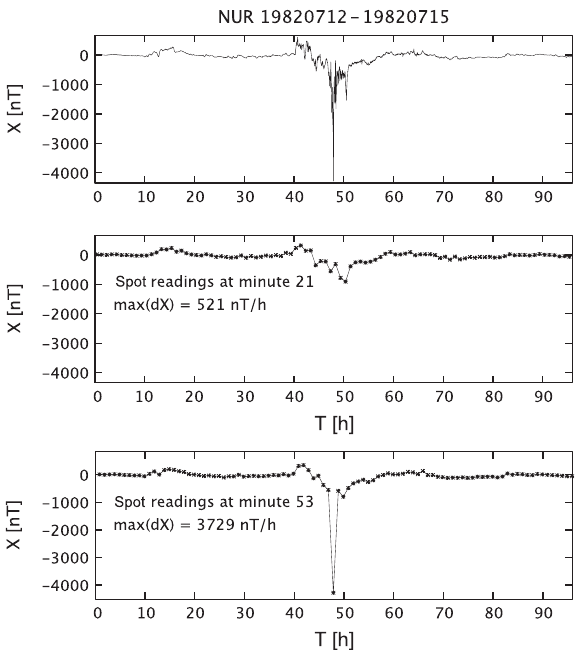
Fig. 2. Top: Original 1-min values of the X component at NUR on 12–15 July 1982. The deepest peak occurs on 13 July at 23:53 UT. Centre: 1-h time series by spot readings at minute 21. Bottom: 1-h time series by spot readings at minute 53.